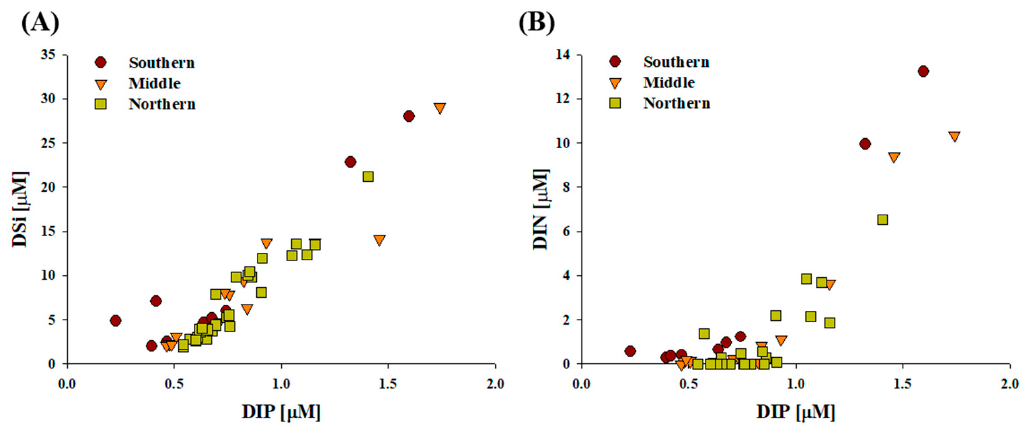
Figure 2. The stoichiometric ( A ) dissolved inorganic silicate (DSi) and dissolved inorganic (DIP) and ( B ) dissolved inorganic nitrate + nitrite + ammonium (DIN) and dissolved inorganic phosphate (DIP) from the surface to euphotic layer at sampling stations.